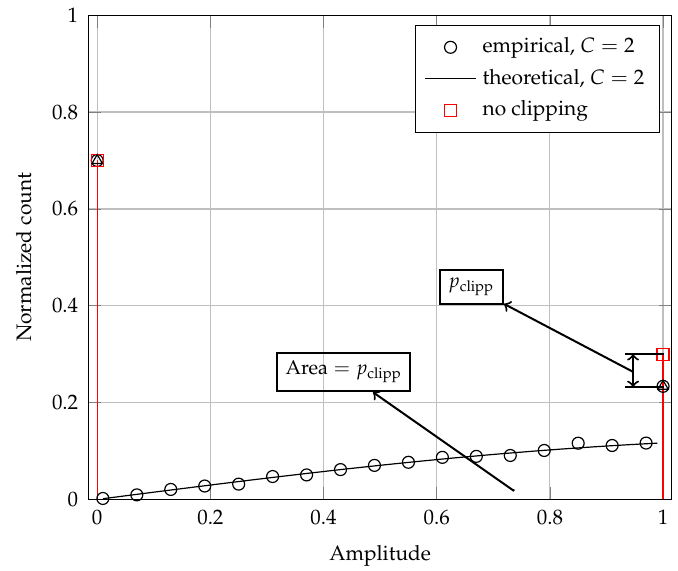
Figure 1. Probability density function of the noiseless received signal samples due to a single SU for p = 0.3, C = 2 and E = 1. The situation of no clipping is also shown for